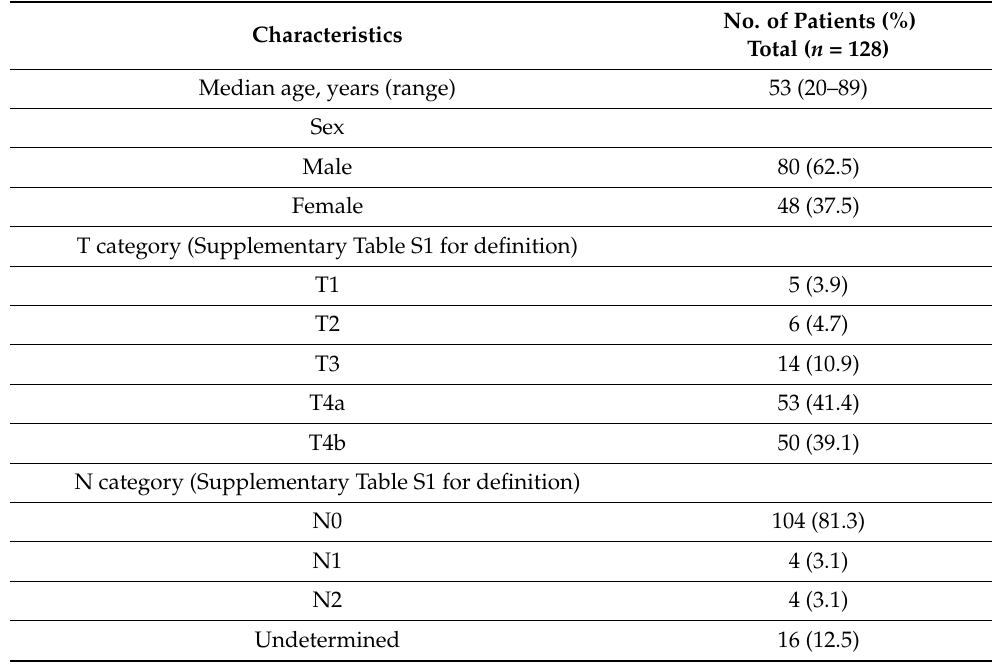
Table 1. Baseline patient